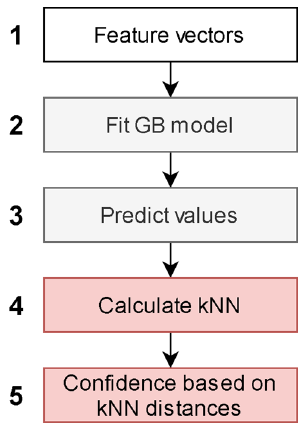
Figure 2. Machine learning-based quantitative structure-activity relationship (QSAR) model.